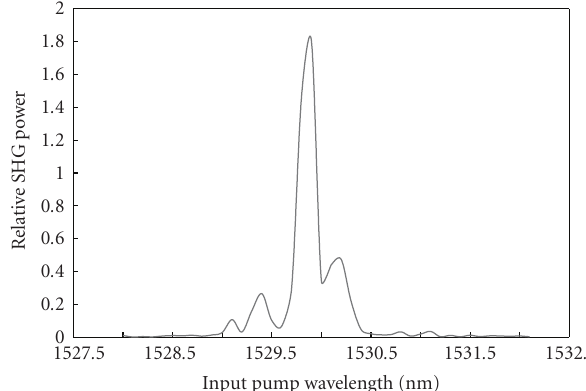
Figure 3: Dependence of second harmonic wave power on the pump